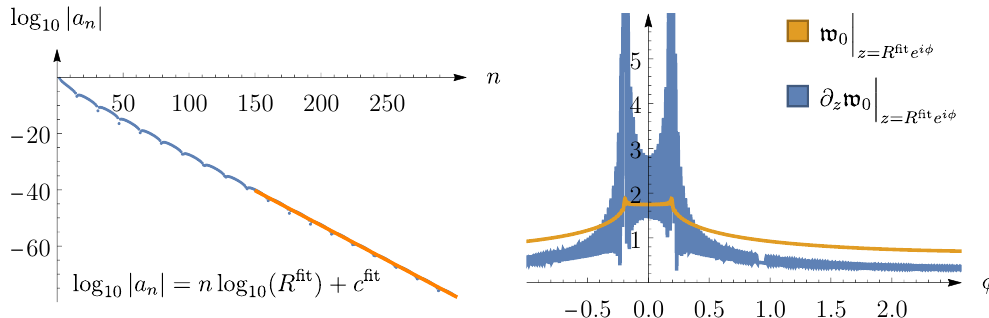
Figure 9. A non-rigorous ‘exploratory’ approach to determining the nature of the obstruction to the convergence of the series (4.12). Left: calculation of the radius of convergence R by use of a simple root test. For the linear fit, we only use the second half of all calculated coefficients. Right: plot of the series representations of w ( z ) and ∂ z w ( z ) for z = R fit e iφ , where φ ∈ [0 , 2 π ] . In this case, one can correctly identify the locations of diverging derivatives with positions of the branch points z 1 and z ∗ 1